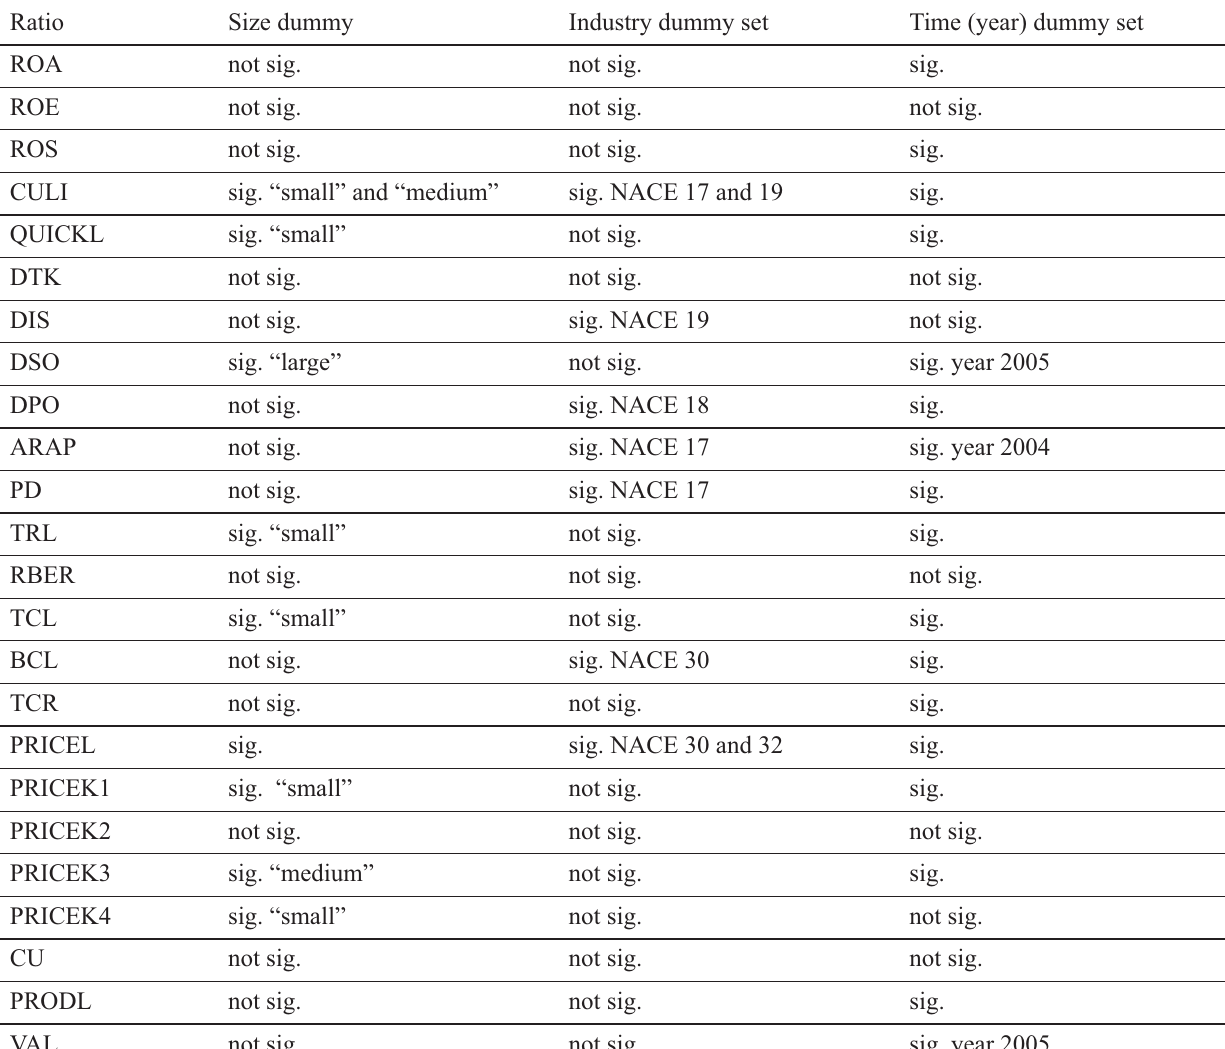
Table 9. Signifi cance of included dummy